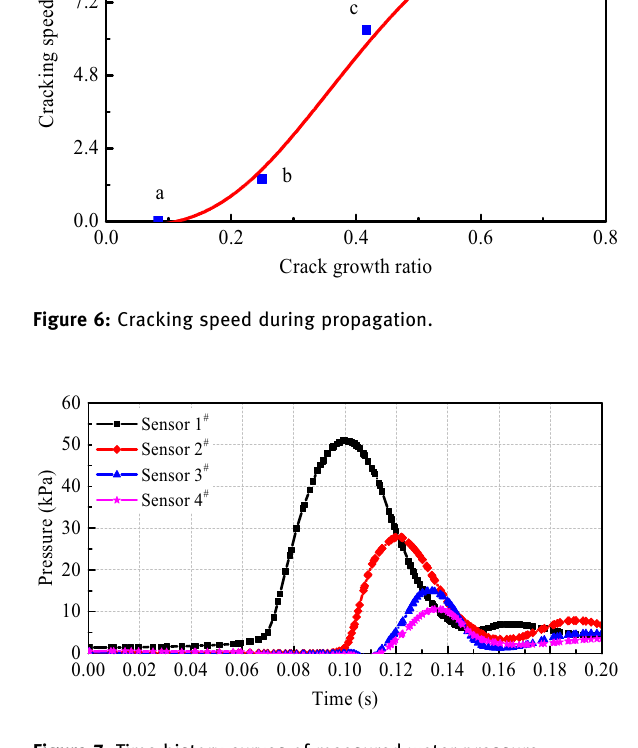
Figure 7: Time history curves of measured water pressure.